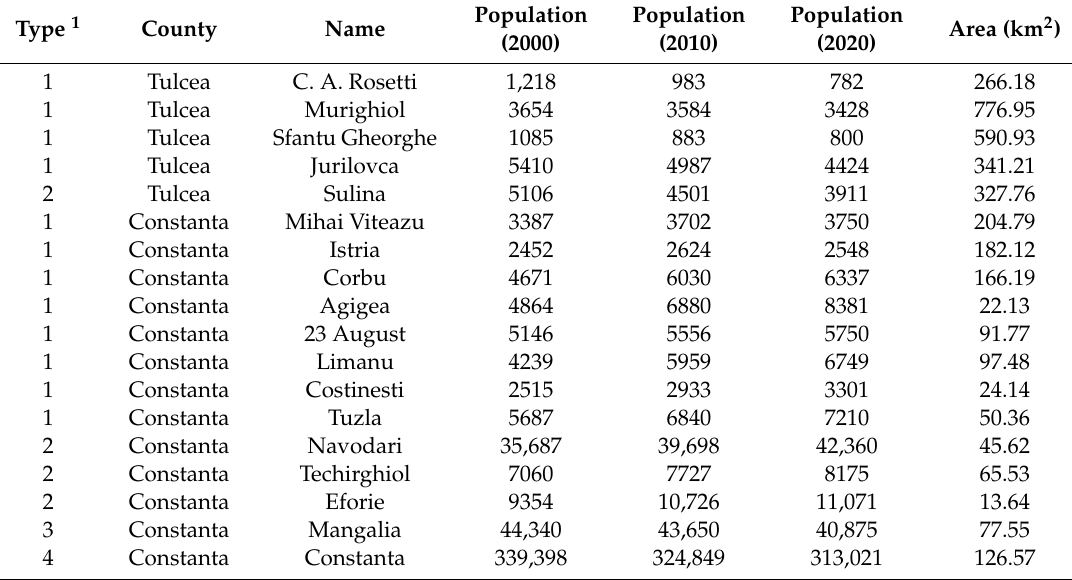
Table 1. Administrative units of the Romanian shoreline and their